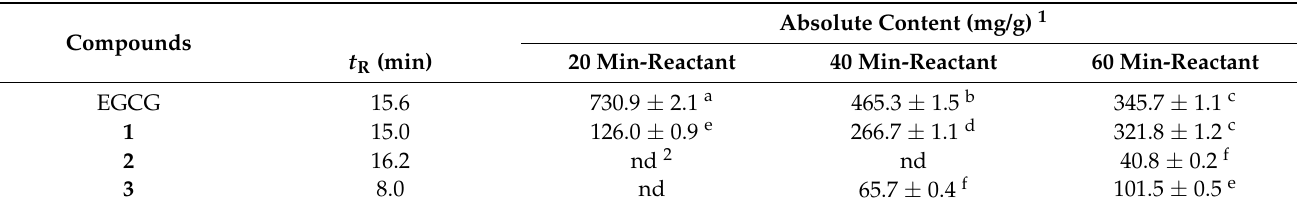
Table 3. Absolute content of individual components in the oxidized